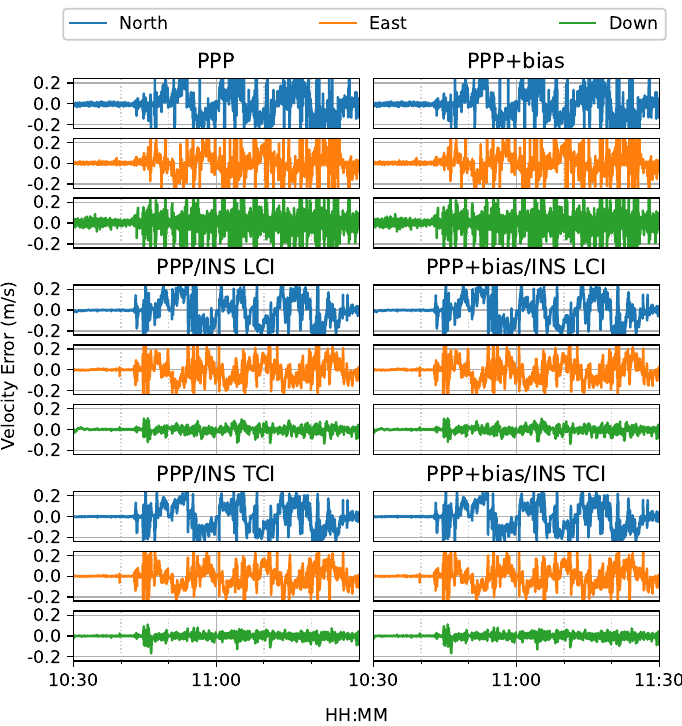
Figure 22. GPS/Galileo PPP/INS velocity results of road bridge test on 11 February 2022 with respect to IE RTK/INS TCI solutions.